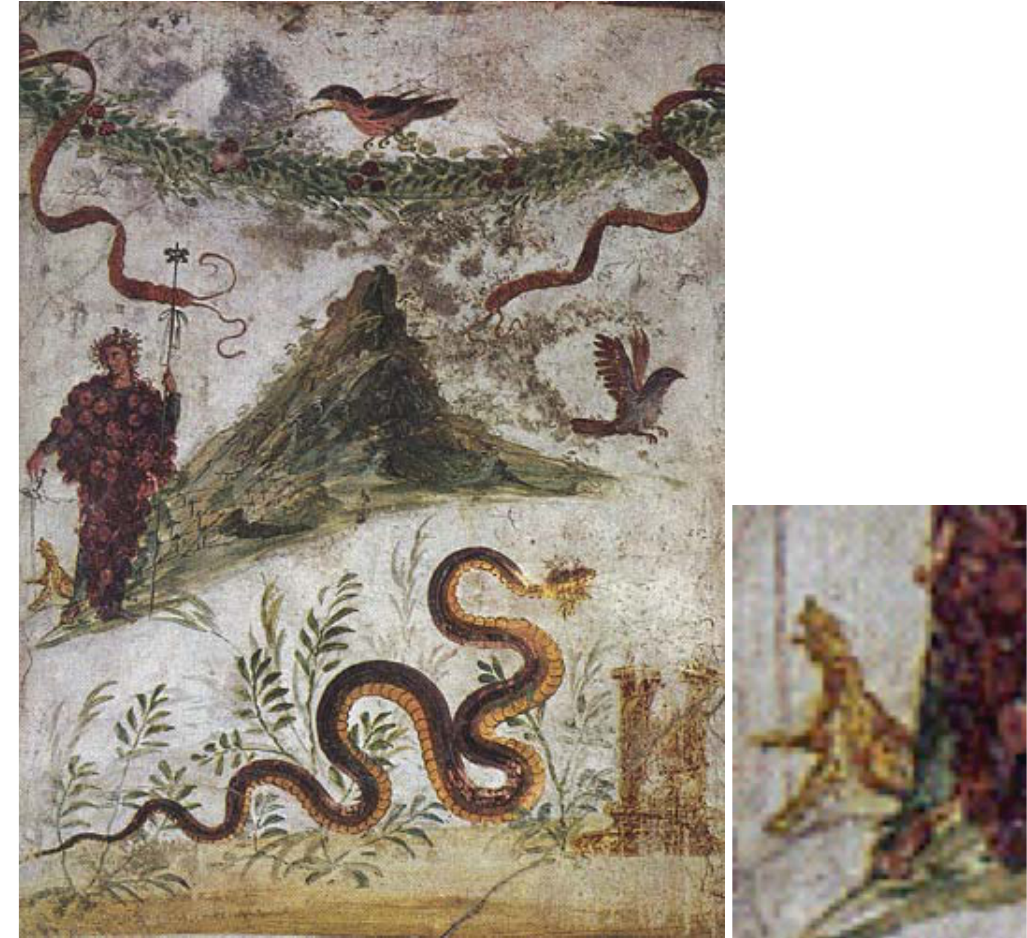
Figure 1. Bacchus and the volcano Vesuvius. Archaeological National Museum Naples, Italy. From Pompeii, House of the Centennial. The traditionally given interpretation of Bacchus together with animals representing the fertility of the land is challenged. It is proposed that excited animals are seen in the company of Bacchus, anticipating a natural (earthquake) disaster. The right hand figure is a magnification of the howling dog behind